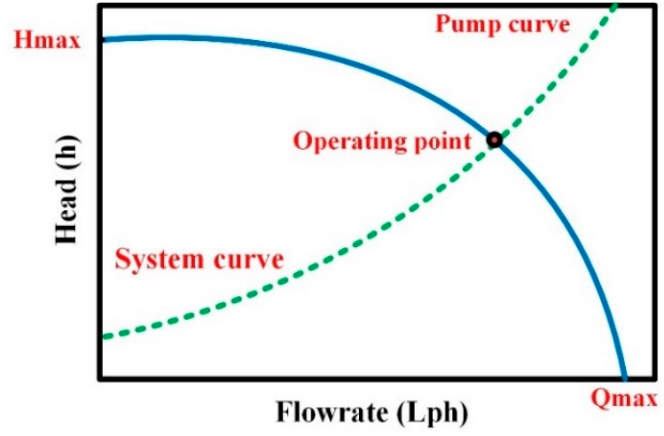
Figure 13. Pump curve vs. system curve.